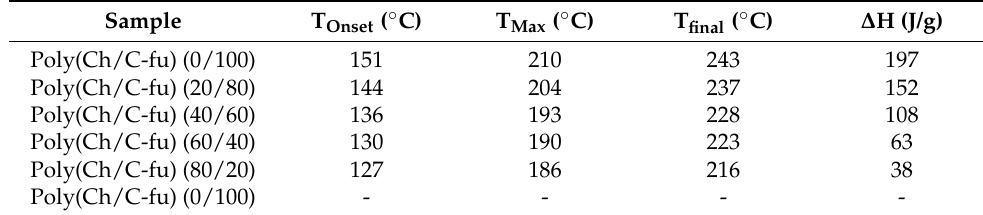
Table 1. DSC data of poly(Ch/C-fu) blends.